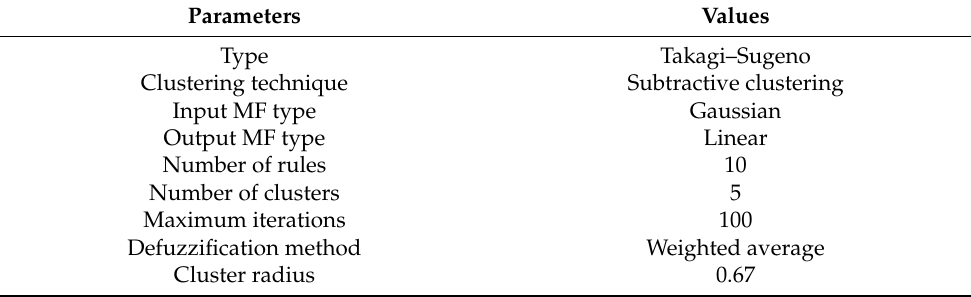
Table 3. The parameters of the ANFIS model.